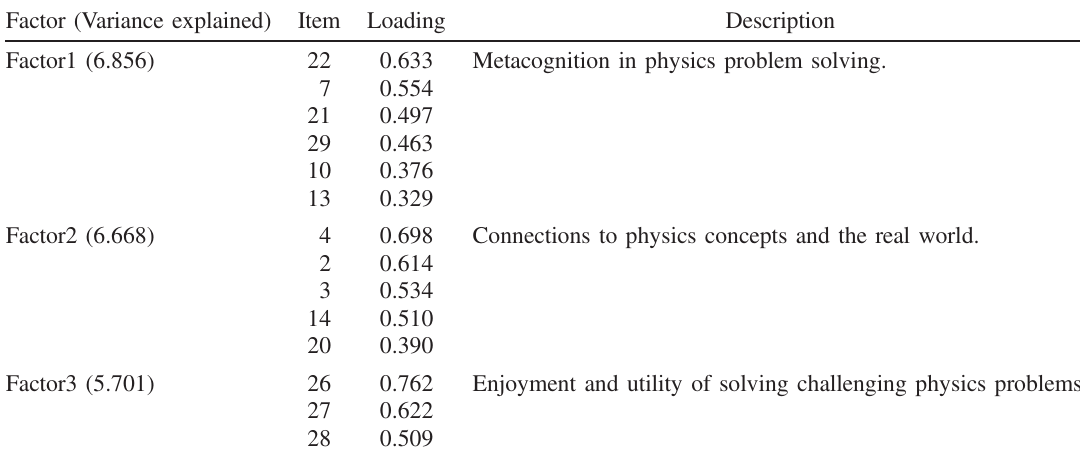
TABLE X. Results of the Principal Component Analysis along with a description of each factor. Factor (Variance